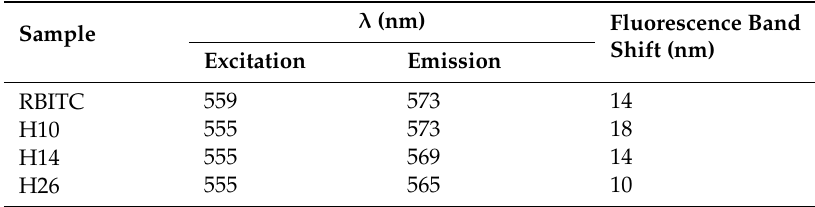
Table 6. Fluorescence excitation and emission wavelengths ( λ ) and shift of fluorescence band for the H10, H14, and H26